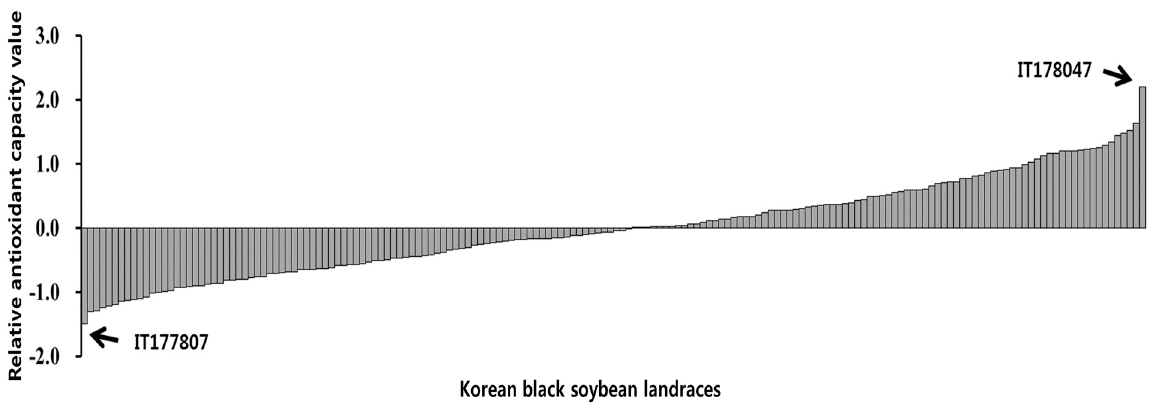
Figure 1. Relative antioxidant capacity index of 172 Korean black soybean landraces.